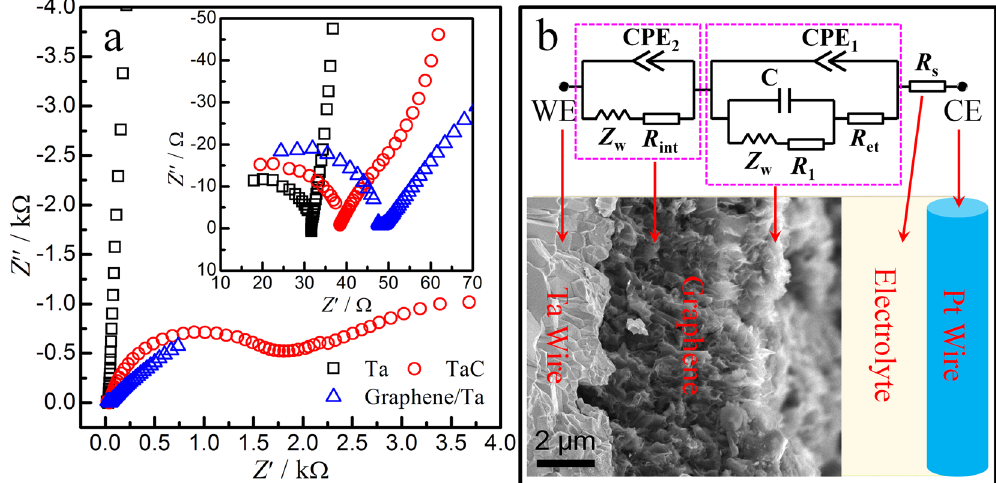
Figure 2. ( a ) Impedance spectra of the Ta wire, TaC/Ta wire, and graphene/Ta wires in 0.1 KCl containing 5 mM K 3 Fe(CN) 6 and 5 mM K 4 Fe(CN) 6